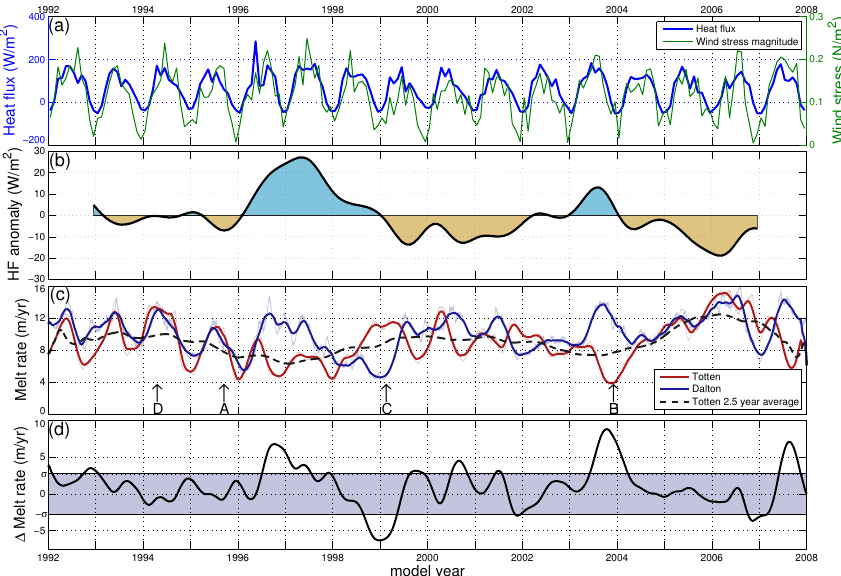
Fig. 2. (a) Heat flux out of ocean from SSM/I observations (Tamura et al., 2008) and the magnitude of wind stress, for the Dalton ice tongue polynya. (b) Difference between monthly heat flux and climatological heat flux (calculated from 1992–2007 data) for respective months, smoothed with a Gaussian filter ( σ filter = 4), and referred to as the “heat flux anomaly”. Heat flux is defined out of the ocean, so positive anomaly periods indicate stronger than average heat loss from the ocean. (c) Model melt rates for the Totten and Dalton ice shelves. The times of the snapshots in Fig. 5 are marked A to D. (d) Difference between melt rates of the Totten and Dalton ice shelves. A positive difference indicates Dalton melting that is stronger than Totten melting. Raw melt rates are smoothed with a 2.5-year moving average filter, ± 1 standard deviation (2.3myr − 1 ) of difference is shaded and years are marked for the 1st of January. In (c) , light blue and light red lines are the raw Dalton and Totten melt rates, blue and red lines are the raw melt rates smoothed with a 3-month moving average filter and the dashed black line is the Totten melt rate smoothed with a 2.5-year moving average